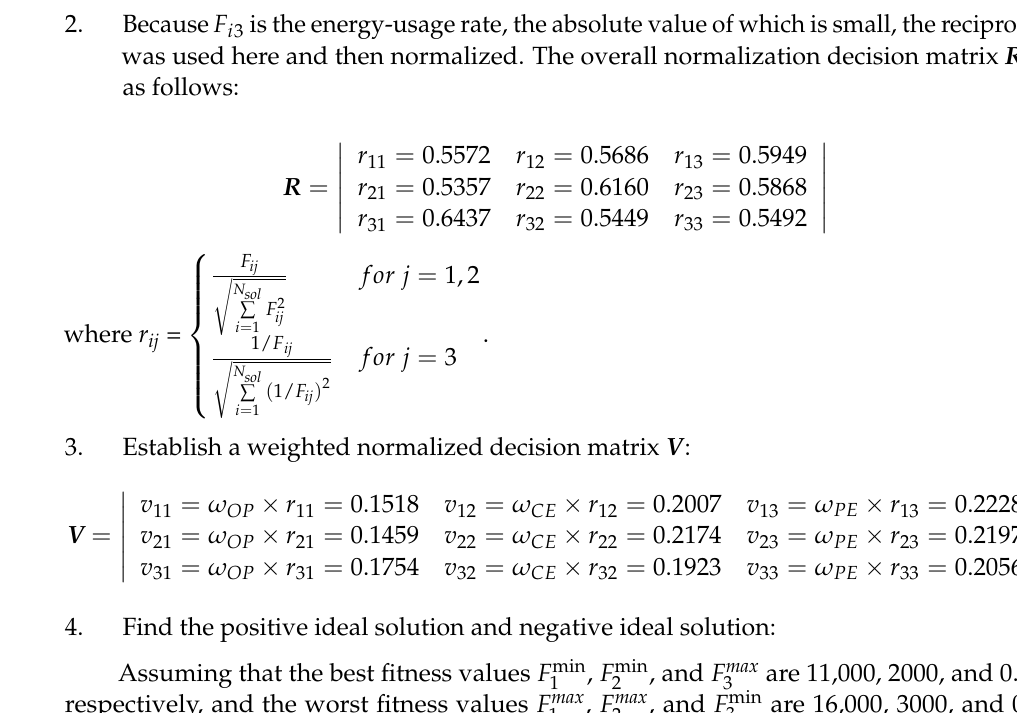
1 are 16,000, 3000, and 0.6, 1